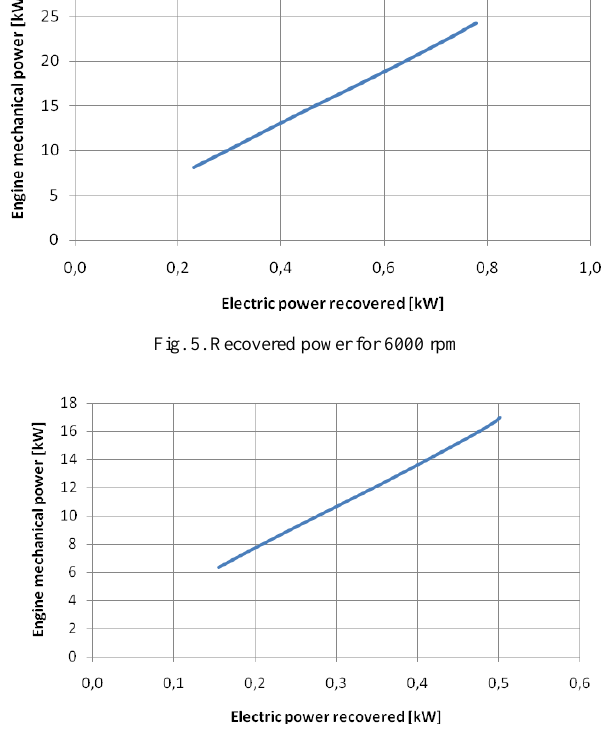
Fig. 6. Recovered power for 4000